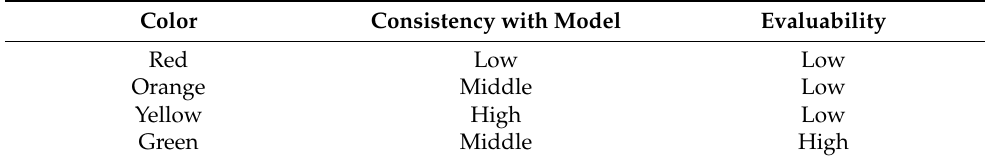
Table 3. Categories for data sets with a small pressure level difference. Color Consistency with Model Evaluability Red Low Low Orange Middle Low Yellow High Low Green Middle High The table indicates how well the data sets correspond to MoFoDatEv. The color red means a low consistency with the model and a low evaluability whereas orange and yellow show middle and high consistency with the model, respectively, but also low